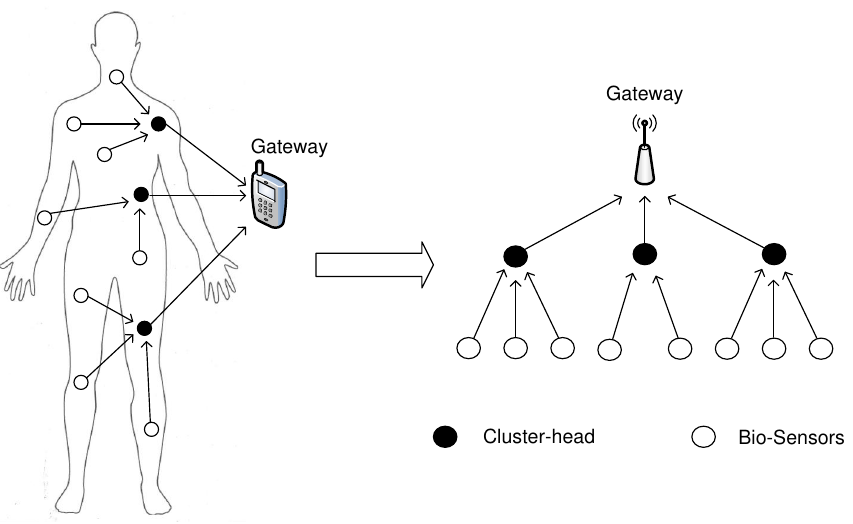
Figure 2. Network model for